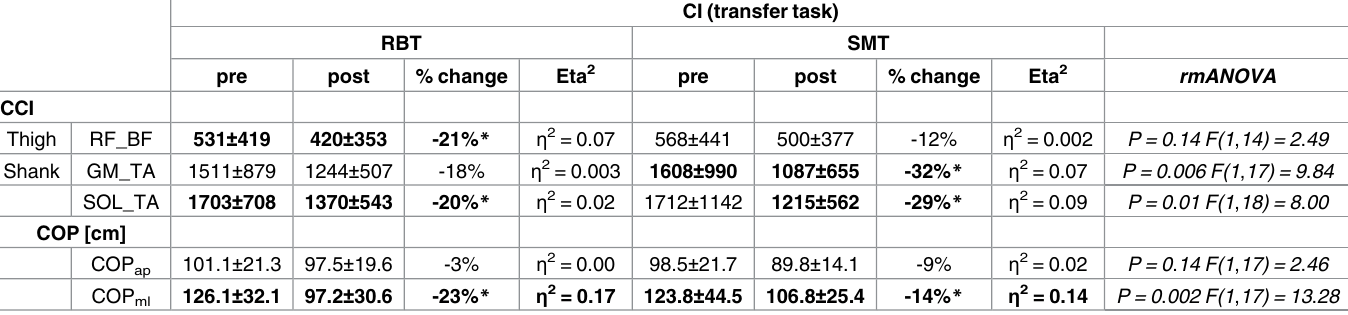
Table 3. Pre and post values of the co-contraction indices (CCIs) and the centre of pressure displacement (COP) during Protocol 3 transfer task with cognitive interference(CI) are illustrated for the two groups RBT and SMT.